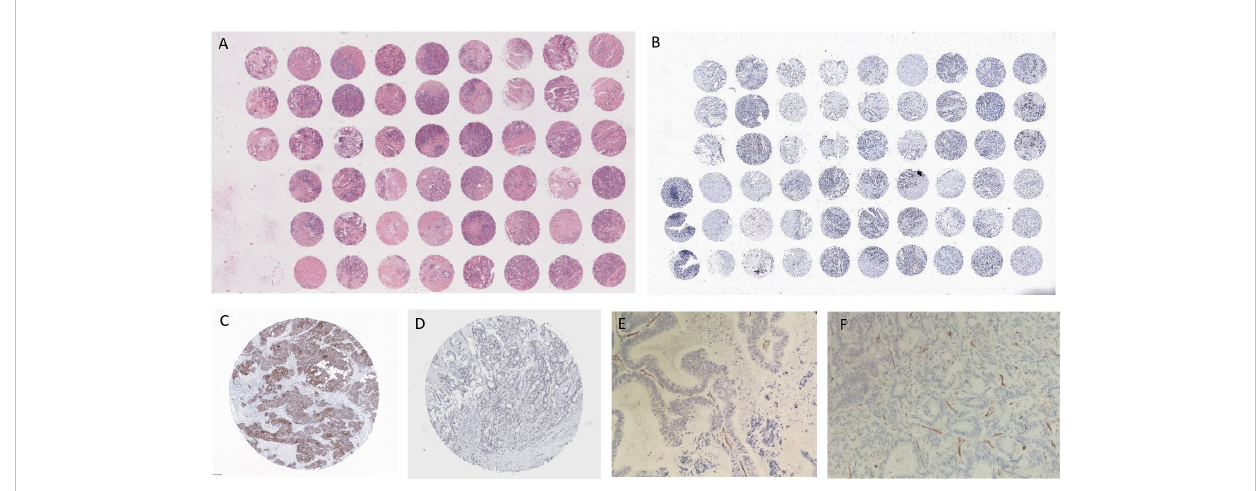
FIGURE 1 (A) TMA, Hematoxylin and Eosin; (B) TMA, NICD; (C) NICD; (D) Jag1; (E) CD31 non responder patient; (F) CD31 responder patient with NICD and